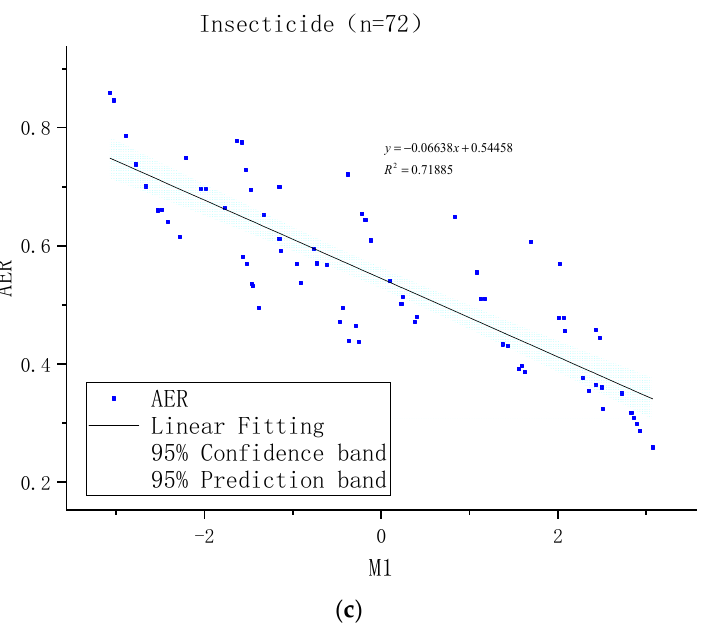
Figure 8. (a): Characteristic value of major components. (b): Elements of the major principal com- Figure 8. ( a ): Characteristic value of major components. ( b ): Elements of the major principal ponent (M1). (c): Correlation between AER of insecticide samples and M1. component (M1). ( c ): Correlation between AER of insecticide samples and